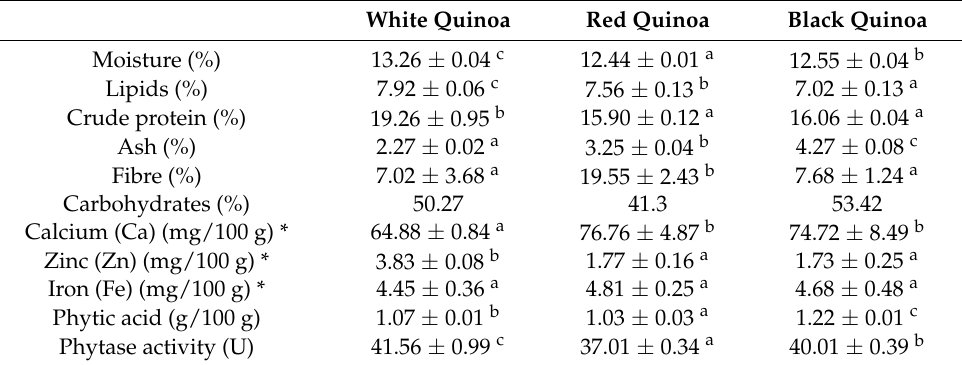
Table 1. Chemical composition of the raw quinoa samples